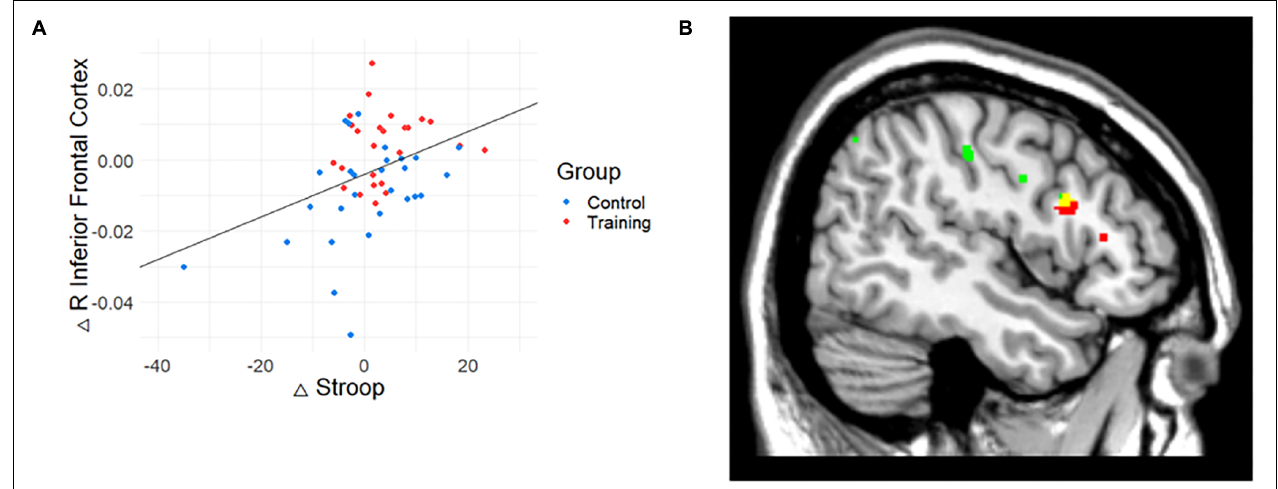
FIGURE 3 | The relationship between gray matter (GM) volume and Stroop performance. (A) The relationship between GM volume and cognitive performance. Change in Stroop test performance was positively correlated with the change in the volume of rIFC. (B) Conjunction map of training-related regions (red) and Stroop-related regions (green). Yellow represents the overlapping areas. The map was illustrated at p < 0.005 (uncorrected) for visualization.